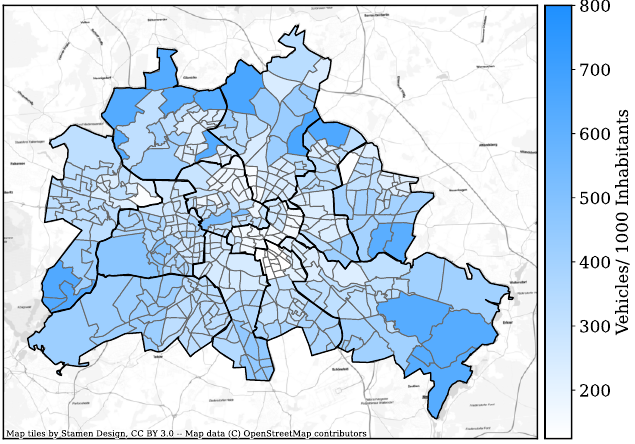
Figure 2. Degree of motorisation in the Berlin LORs.